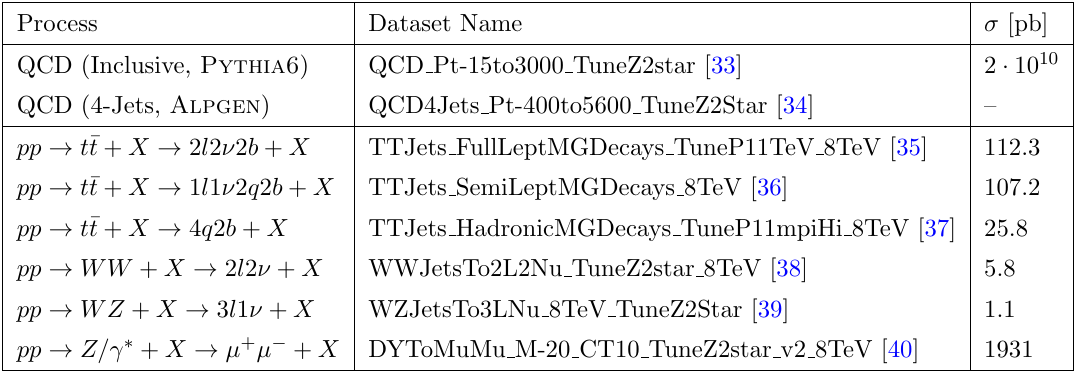
isolation e(cid:14)ciencies as well as in the momentum and energy scales and resolutions